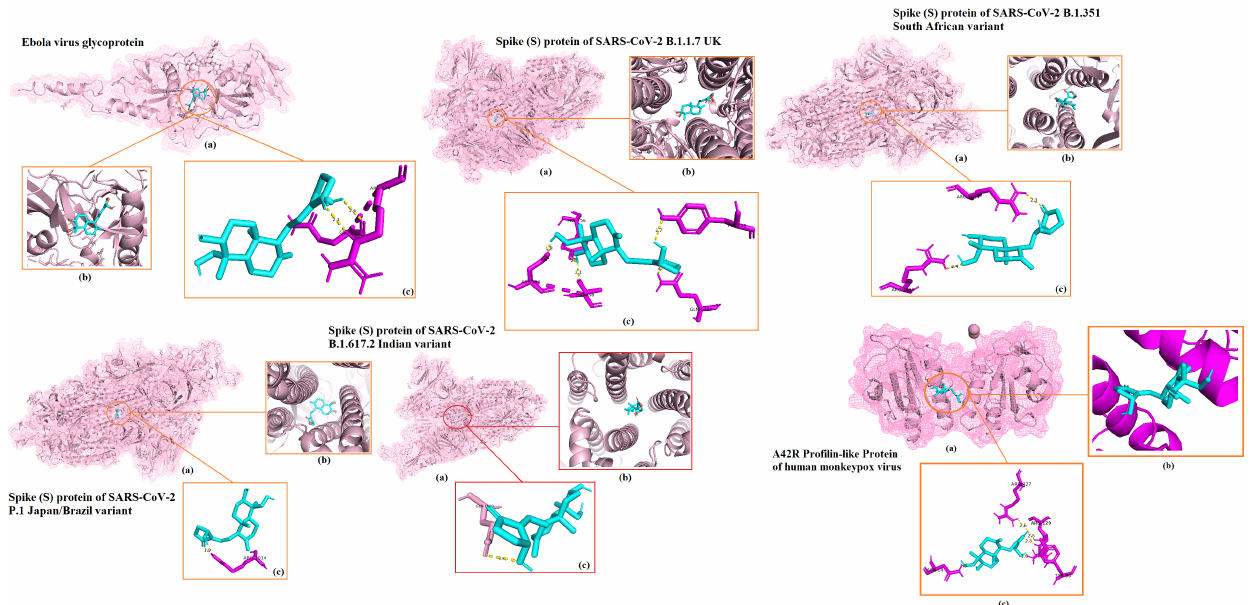
Figure 3. Results of the docking analysis showing the 6main binding sites of andrographolide with the different viral surface proteins. The molecular interactions in the 3D structures were visualized in PyMOL. ( a ) Indicates binding domain. ( b ) Binding site. ( c ) Interacting amino acids of receptor (purple) and ligand